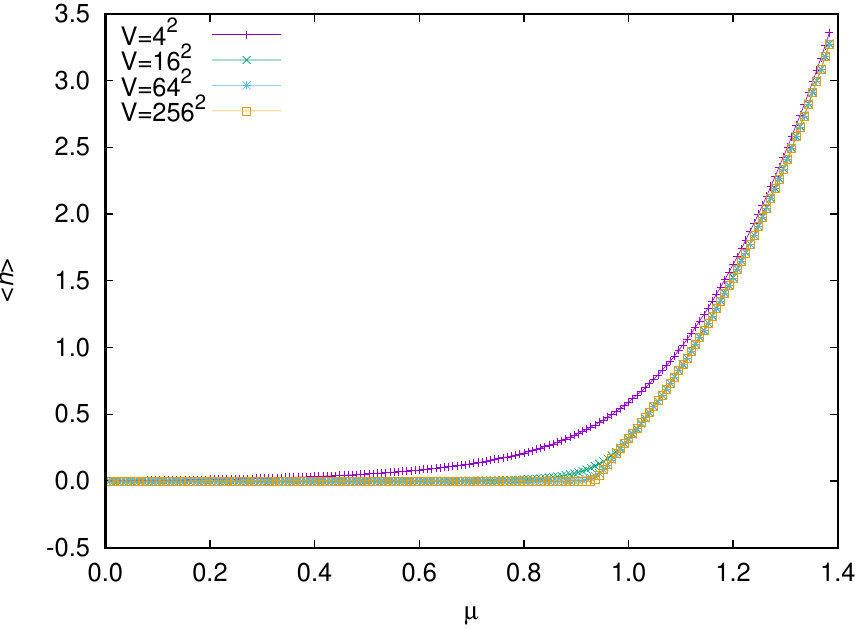
Figure 4 . h n i as a function of (cid:22) . The lattice volume is varied from 4 2 to 256 2 . The other parameters ( m , (cid:21) , K and D ) are the same as those of (cid:12)gure